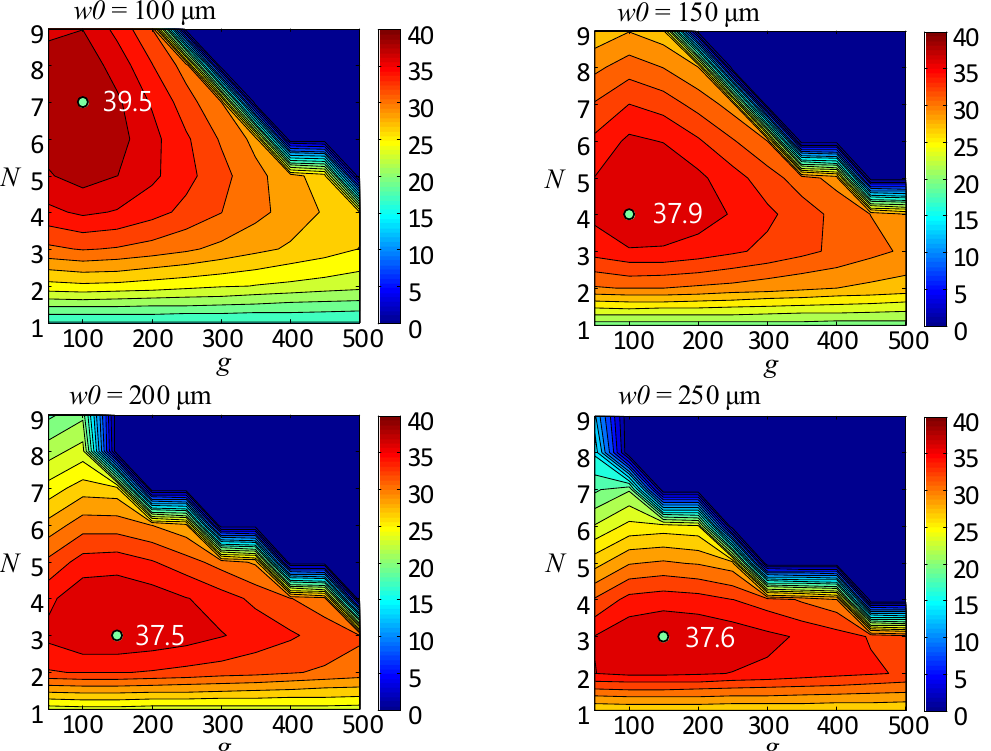
Figure 7. The calculated Q-factor according to g and N for the double-layer planar spiral coil with w 0 = 0.1, 0.15, 0.2, and 0.25 mm.